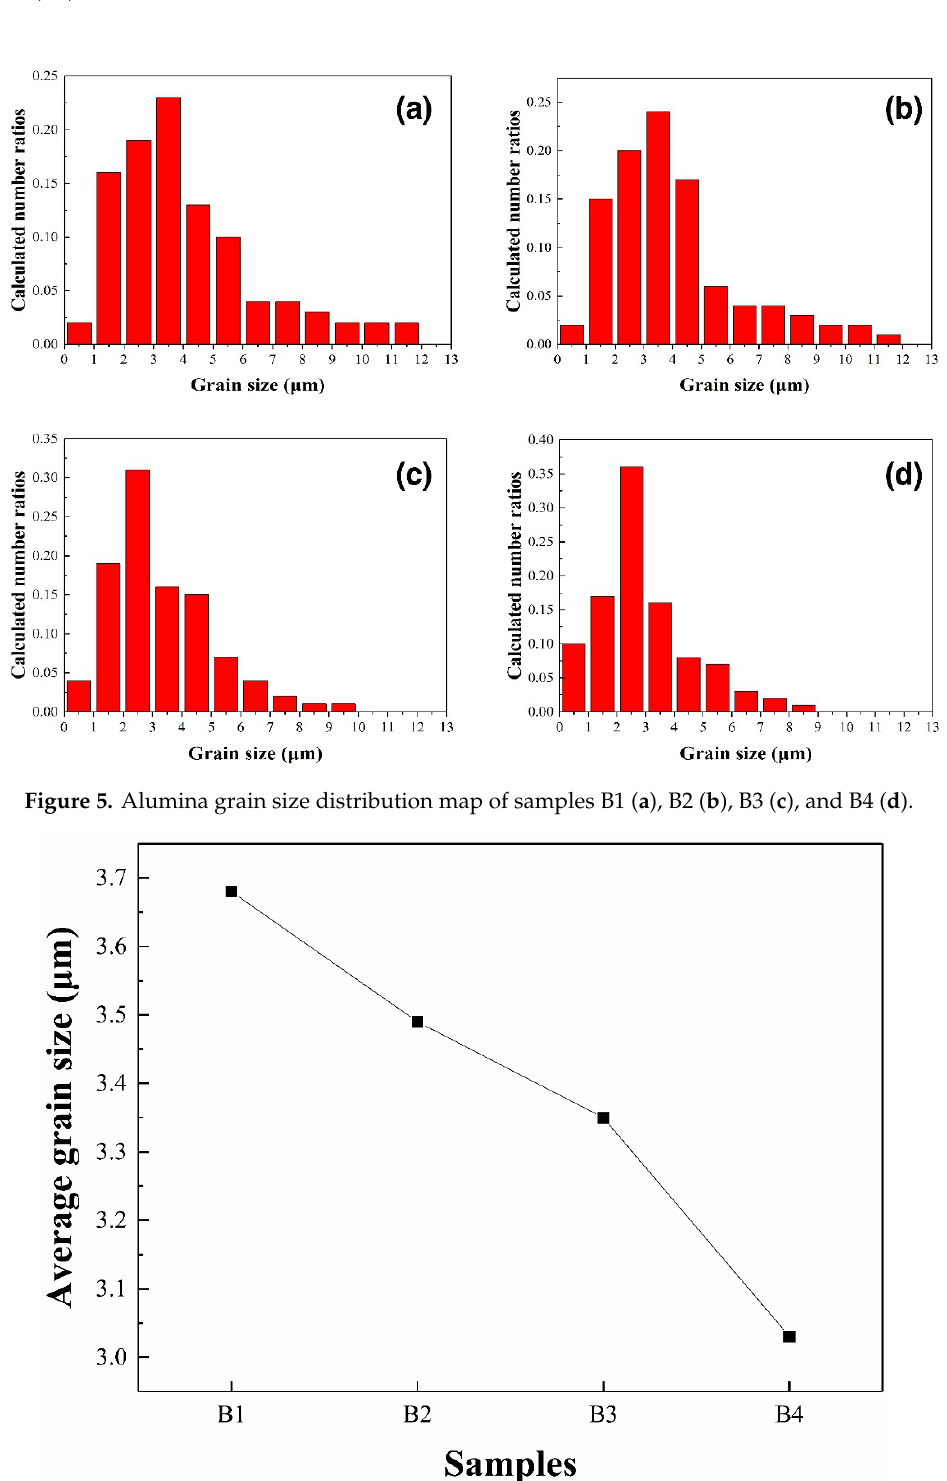
Figure 6. Average size of alumina grains in samples B1–B4.